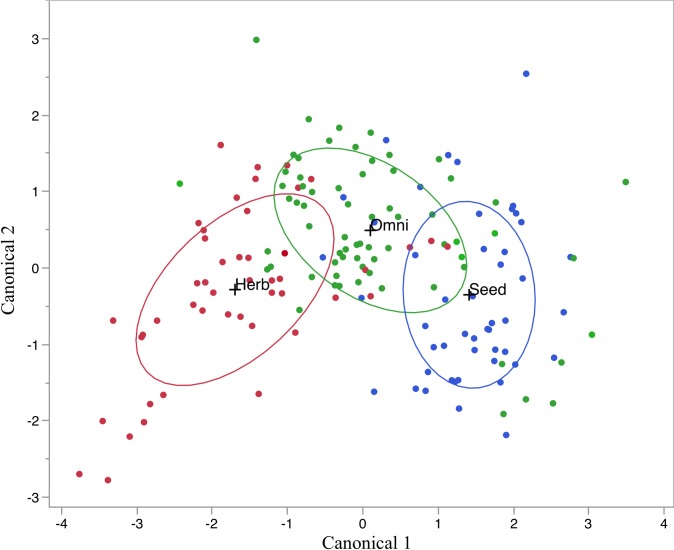
QDA model predicting modern rodent diets.The measures OA/MD, OD/DE, BD/MD, and RC/MD were used. Herbivores = red, omnivores = green, seed eaters = blue. Ellipses represent 50% of the distribution of each dietary category. Wilk’s Lambda = 0.345, F = 27.55, p<0.0001.